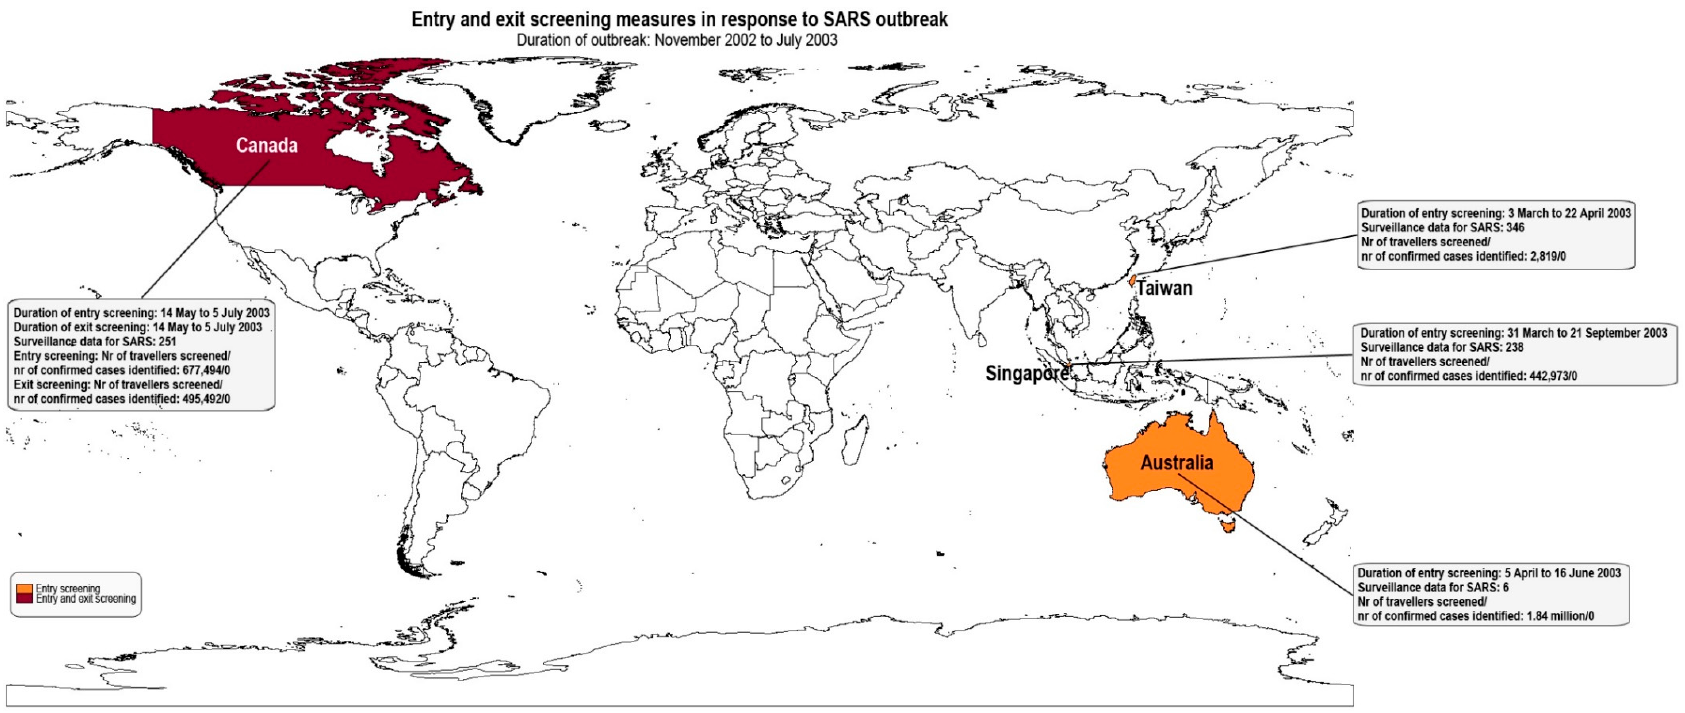
Figure 2. Published entry and exit screening measures in response to SARS outbreak [8,9,23,35,42].